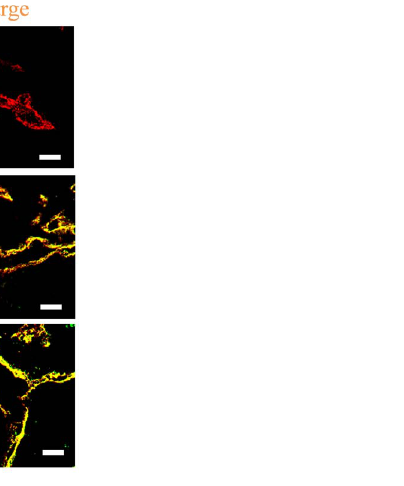
Figure 6. ALDH is expressed in human tumor blood vessels. Double immunofluorescence staining for endothelial markers CD31 and ALDH in normal human kidney tissue (a–c) and RCC tumor tissue (d–i). Merged images show co-localization of ALDH (green) and CD31 (red) in situ. Scale bar: 40 m